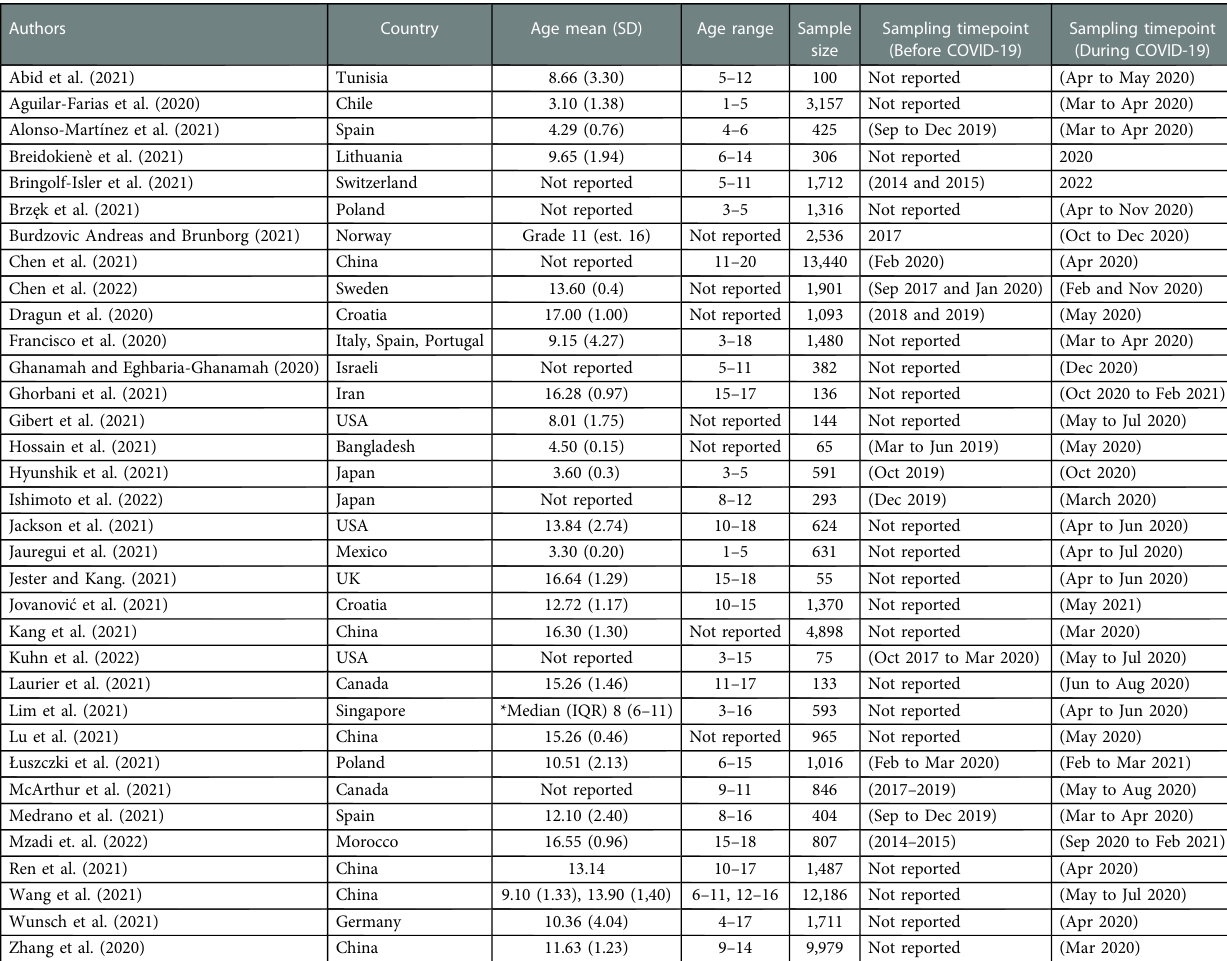
TABLE 1 Characteristics of included